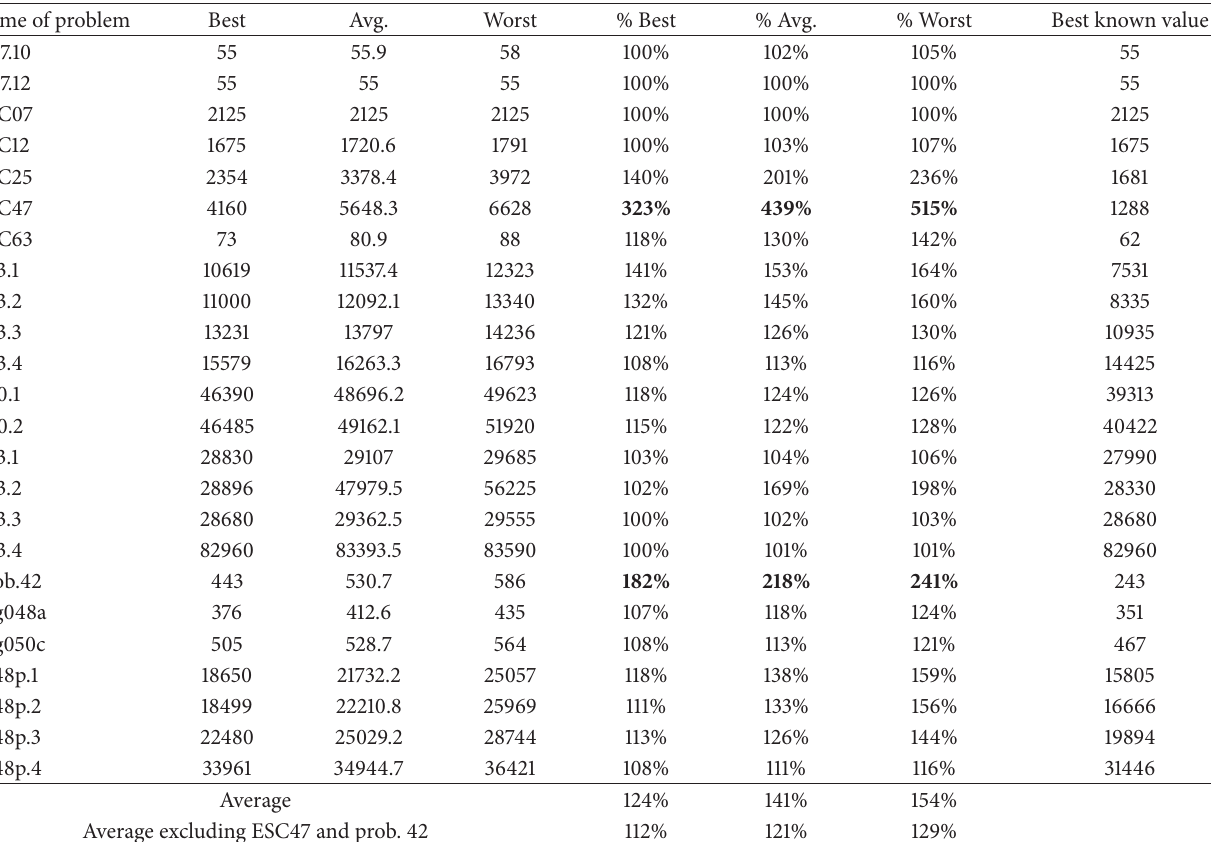
Table 6: Comparison against best known values using the best options for each